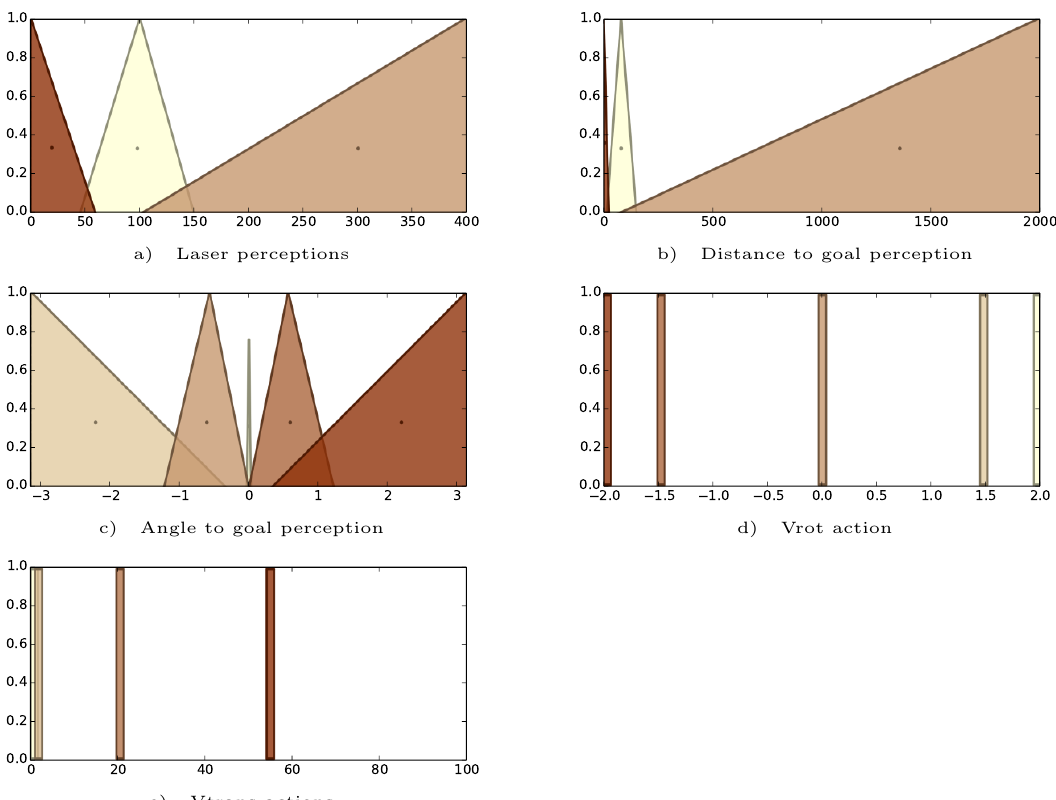
Figure 1. Fuzzy terms and sets for the microscopic controller. This controller was executed by each robot member of the swarm. ( a ) Fuzzy set used for the perception of lasers. The available readings were discretized into three groups (left, right, front), where each one contained three angle readings. The terms for this set are near, far, and emergency (emer). ( b ) Fuzzy set dist, which specifies the distance to the goal. The terms in this set are near, med and far. ( c ) Fuzzy set ang, which was used to represent the angle of the box with respect to the goal. The terms used are far left (farl), medium left (medl), near, medium right (medr) and far right (farr). ( d ) Fuzzy set that represents the rotational speed of the robot. The terms are high left (hleft), left, none, right and high right (hright). The Takagi–Sugeno weighted average was used as a defuzzifier, with a default value of 0. ( e ) Diffuse set, which represents the rotational speed of the robot. The terms are stop, low, medium and high. The Takagi–Sugeno weighted average was used as a defuzzifier, with a default value of